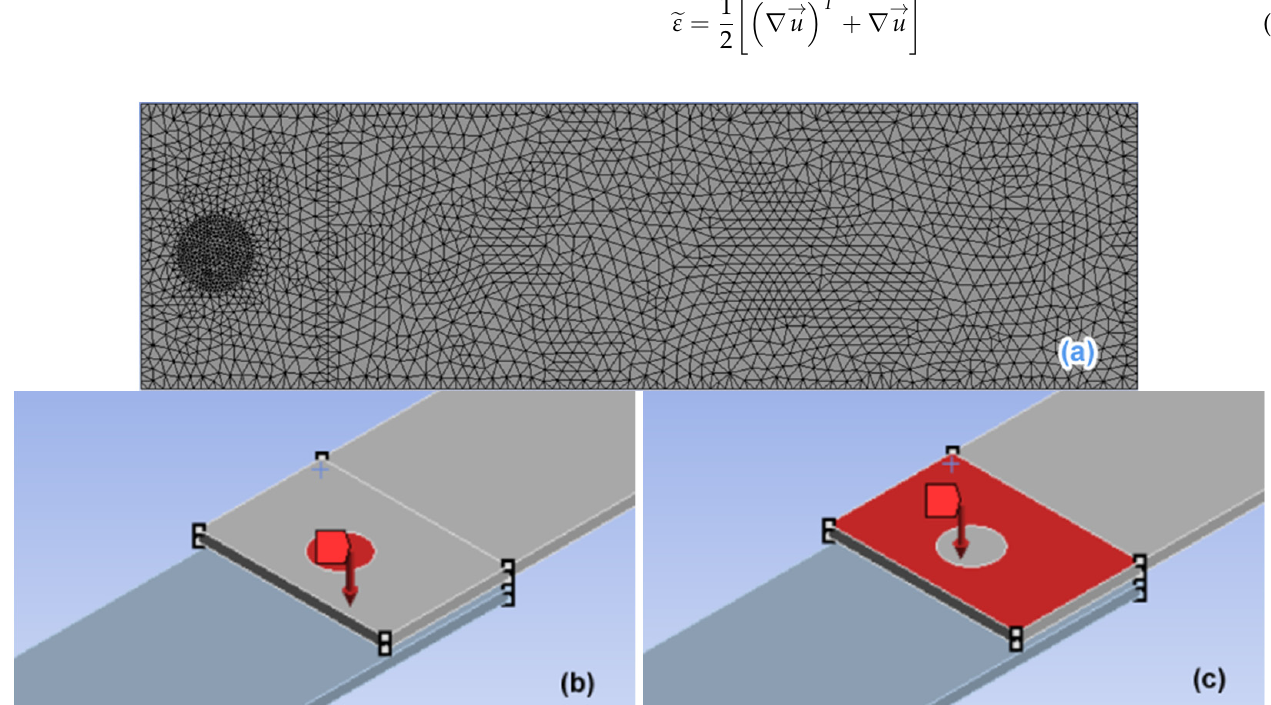
Figure 11. Pressure diagram of the lap region. ( a ) Mesh division of upper welding workpiece, ( b ) static pressure area, and ( c ) preload area.